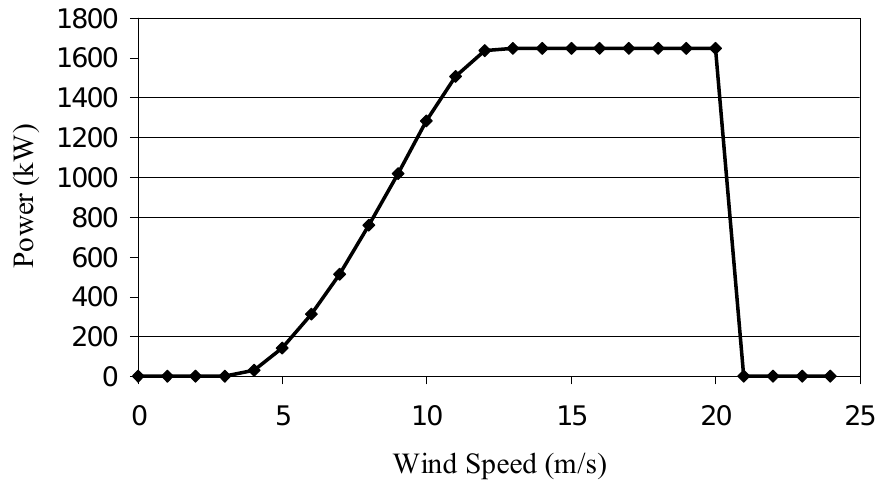
Figure 2. The power curve for the Vestas V82 1.65 MW turbine is shown [17]. An air density of 1.225 kg/m 3 is assumed.